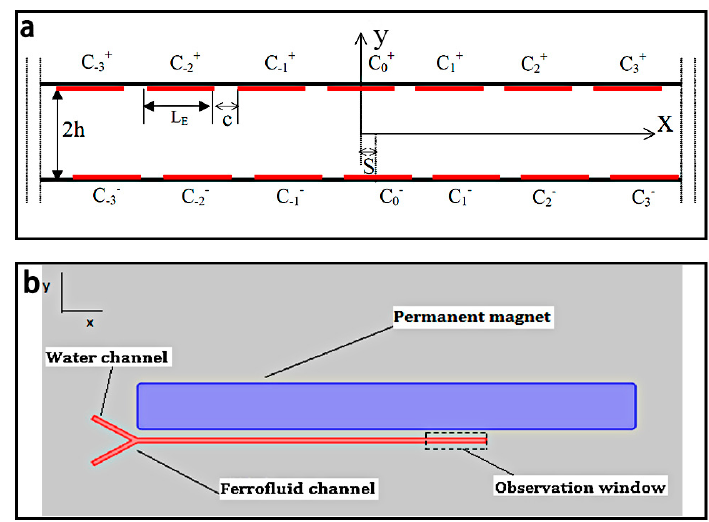
Figure 6. ( a ) Schematic of the magneto-hydrodynamic micromixer. L E is the width of the electrodes, c is the width of the space between two adjacent electrodes, S is the offset of two facing elecrodes, and 2 h is the width of the conduit; ( b ) Schematic of the ferrofluid-based magnetic micromixer with Y-shaped channel. Reproduced with permission from [57,83].